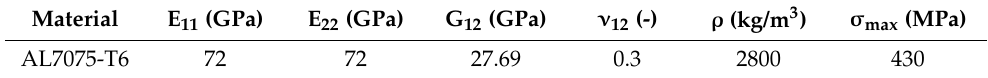
Table 3. Aluminum alloy properties.